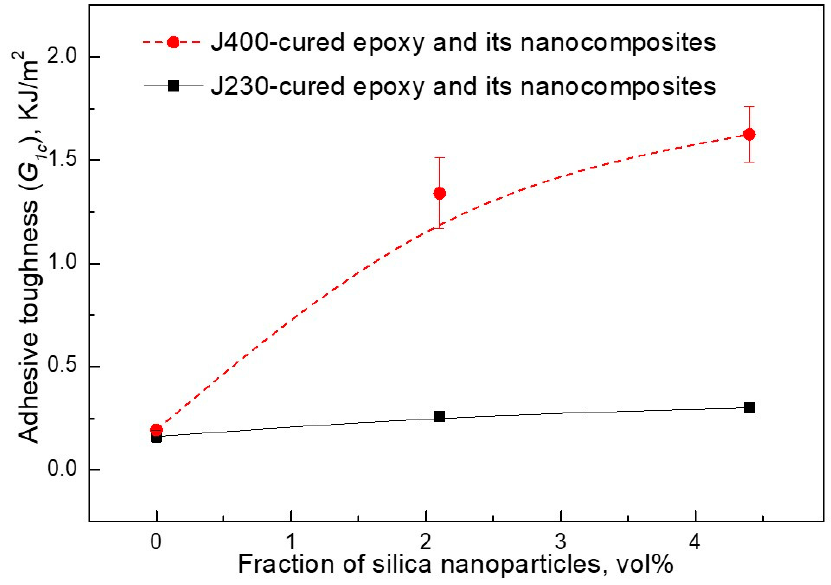
Figure 11. Toughness increase of epoxy adhesives by the addition of nanosilica for a brittle (J230) and a ductile (J400) adhesive [42].